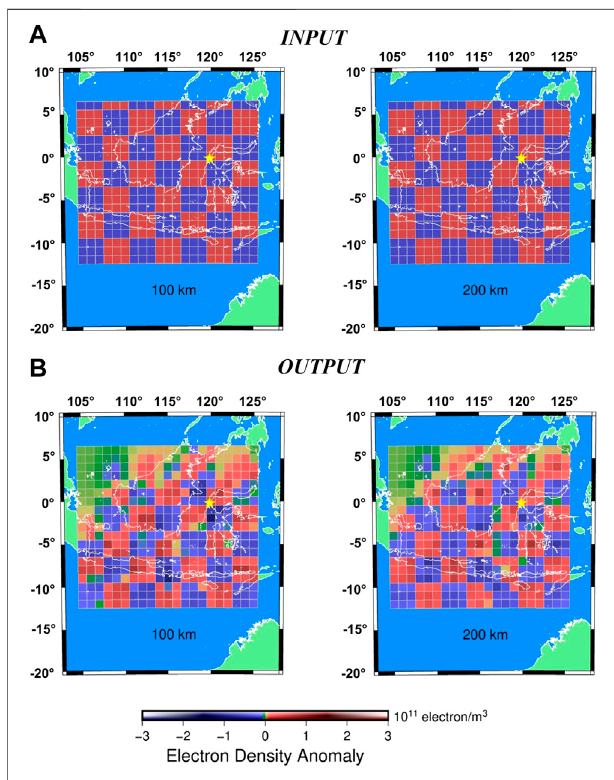
FIGURE 4 | (A) The 3D pattern of electron density anomalies for the checkerboard resolution test. (B) Results of the checkerboard resolution test of the